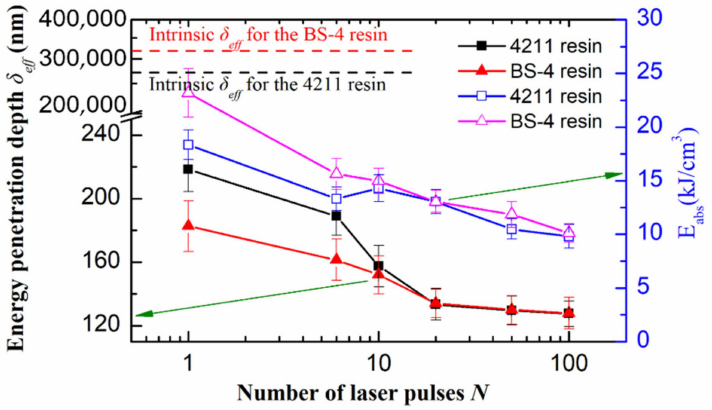
Figure 8. Influence of number of pulses on effective energy penetration depth ( δ eff ) and absorbed energy density ( E abs ) at the ablation